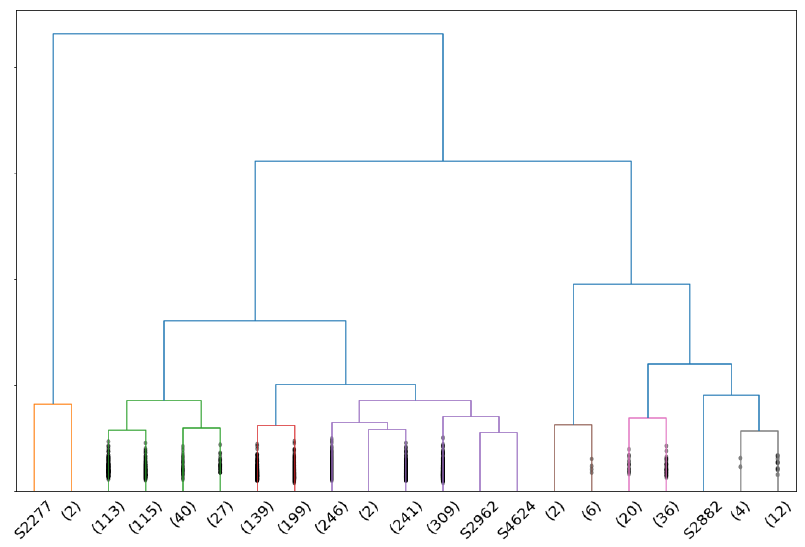
Figure 7. Dendrogram associated to a complete-linkage hierarchical clustering of the persistence diagrams of male point clouds with the Wasserstein distance. Clusters composed of one individual are presented without